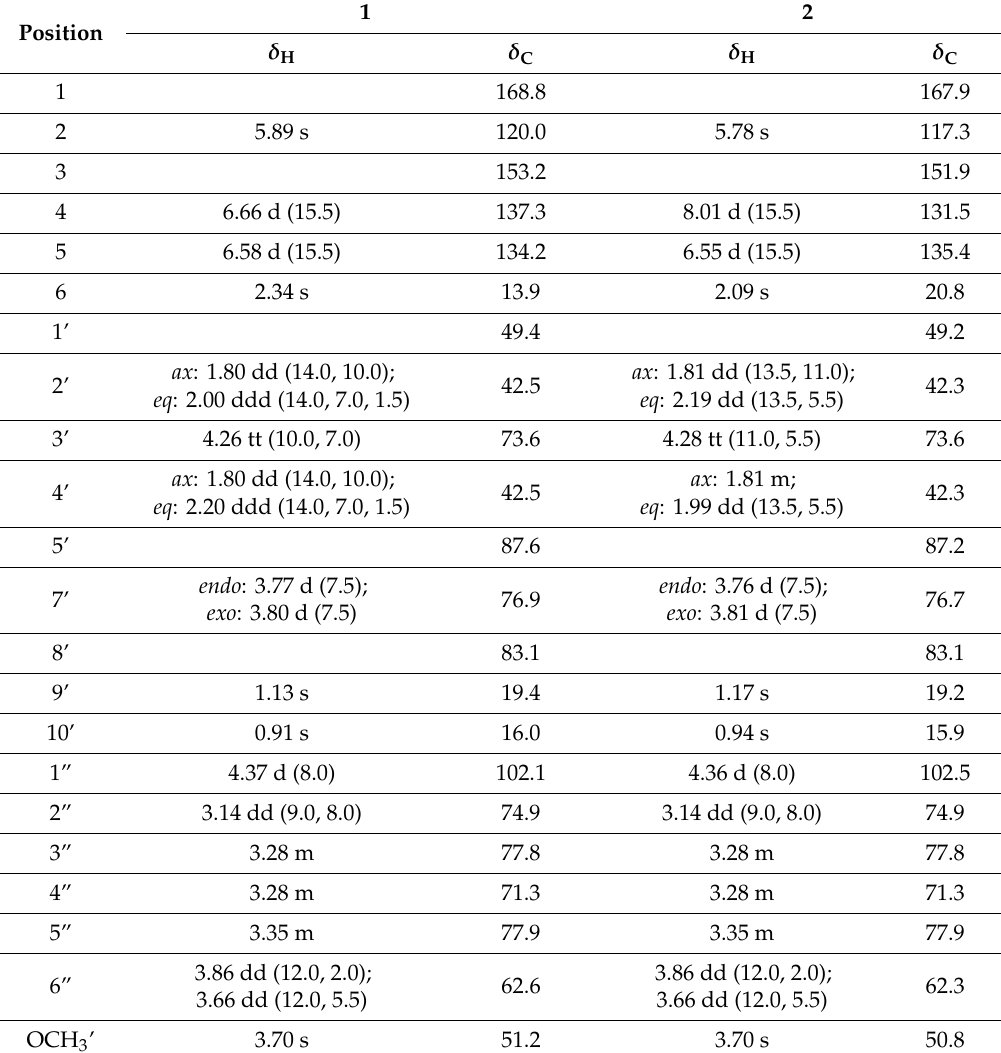
Table 1. 1 H and 13 C NMR data of compounds 1 and 2 in CD 3 OD ( δ in ppm, 850 MHz for 1 H and 212.5 MHz for 13 C) a